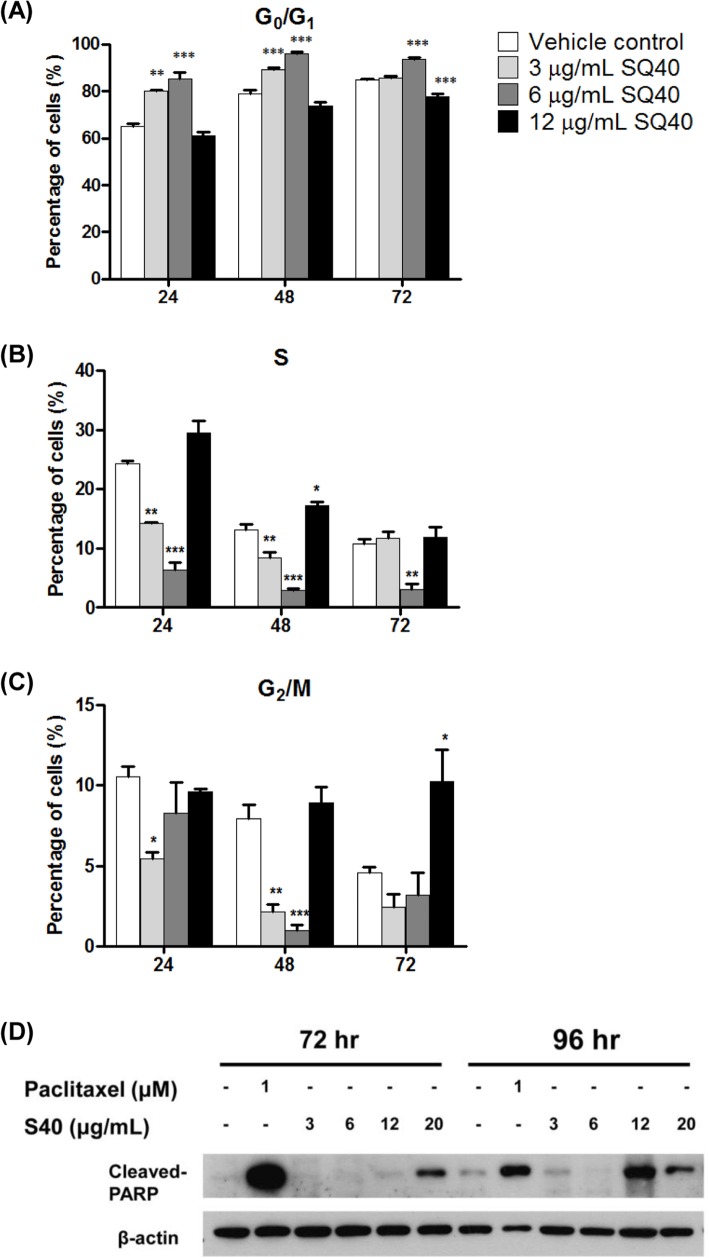
Cell cycle distribution of LNCaP cells upon SQ40 treatment.LNCaP cells were treated with growth media (vehicle control), 3, 6 and 12 μg/mL of SQ40. Cell distribution in (A) G0/G1, (B) S and (C) G2/M phase at 24, 48 and 72 hours treatment were analysed by FACSCanto II flow cytometry and evaluated using ModFit cell cycle analysis software. Data were expressed as means ± SEM of three independent experiments. * indicates p<0.05; **, p<0.01; ***, p<0.001 versus vehicle control. (D) Protein expression of cleaved-PARP in LNCaP cells upon SQ40 treatment for 72 and 96 hours. β-actin served as a loading control.